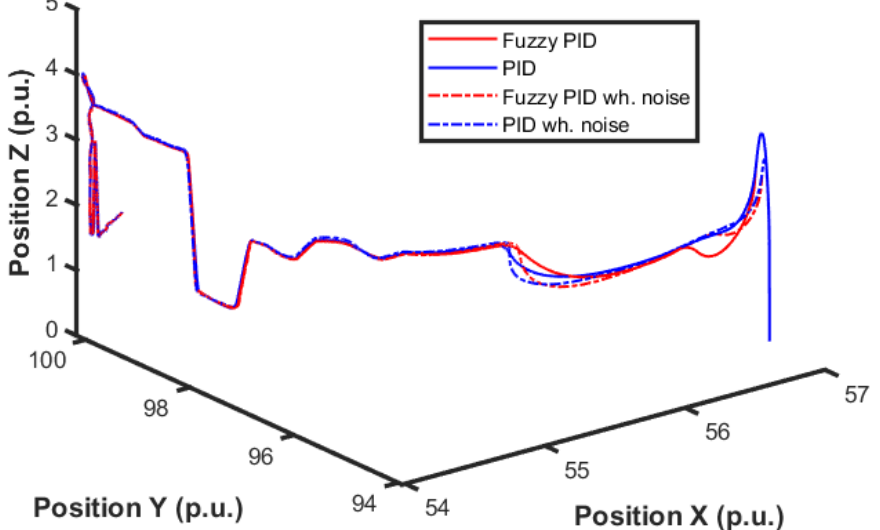
Figure 17. 3D visualization for the comparison of the proposed method among other approaches for position control.